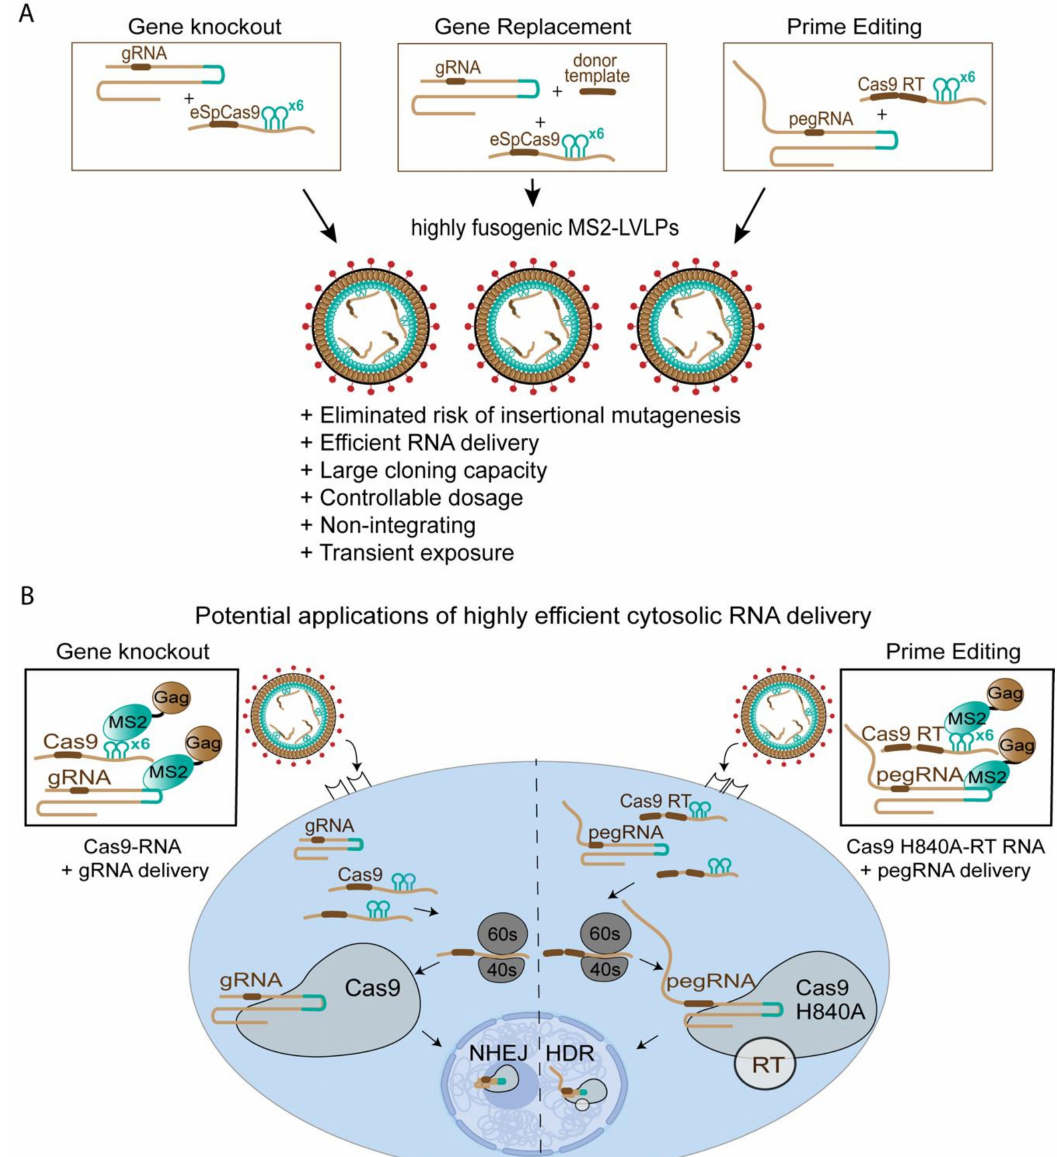
Figure 4. Overcoming current limitations of viral vectors in the era of genetic engineering and gene therapy through MS2-LVLP-based cytosolic RNA delivery. ( A ) Summary of advantages of transient ‘hit-and-run’ genome editing using MS2-LVLPs. ( B ) Simplified schematic of transient RNA delivery in the context of current gene editing technologies using cell-specific, non-integrating